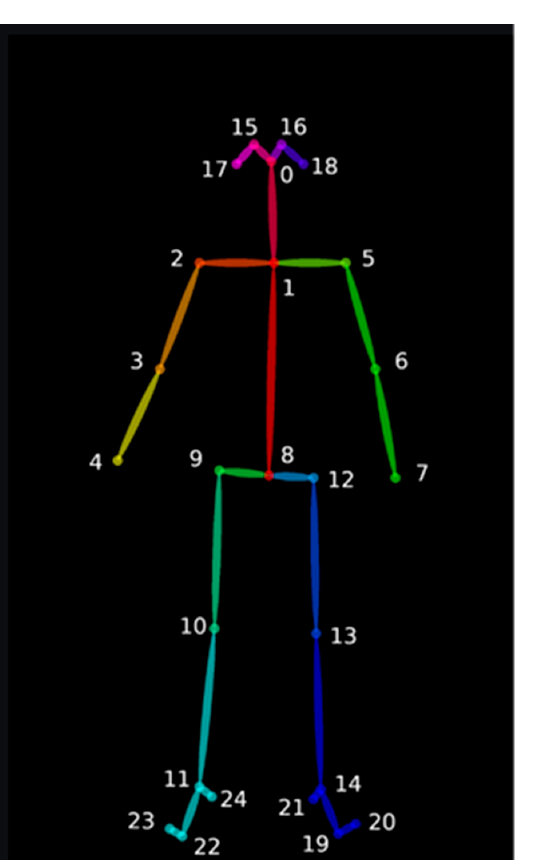
Figure 1. Architecture flowchart.